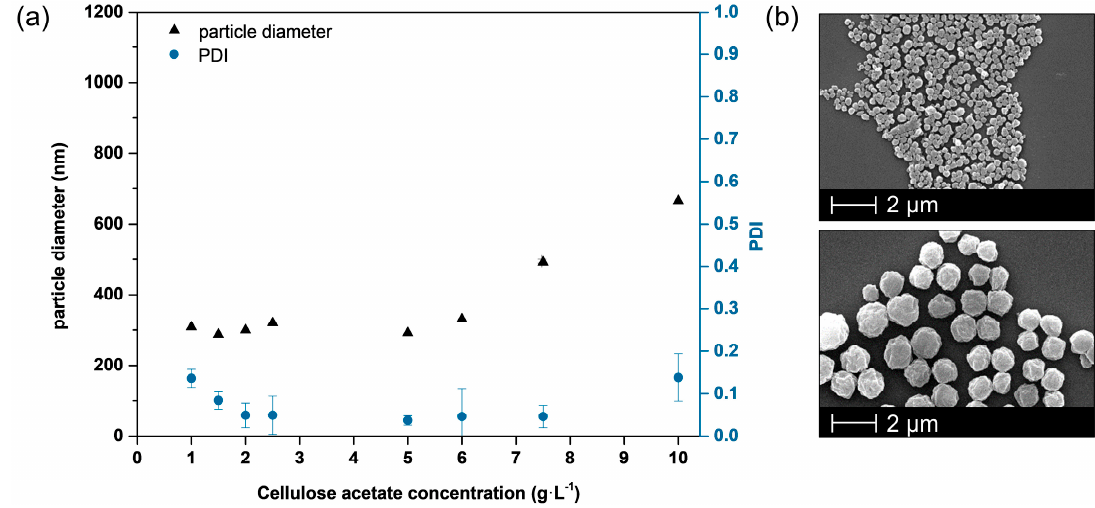
Figure 3. Adjustment of nanoparticle size by polymer concentration prior to nanoprecipitation process ( a ) leading to larger particles at higher concentrations without influencing the surface morphology ( b ).